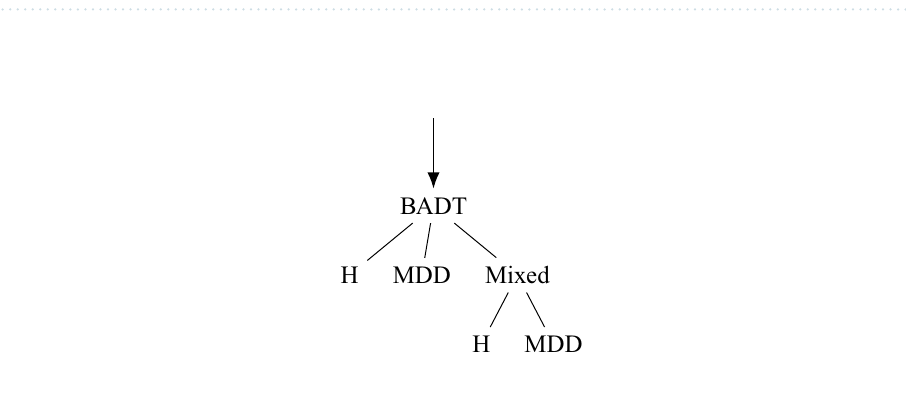
Table 4. Comparisons with other algorithms from literature. Significant values are in